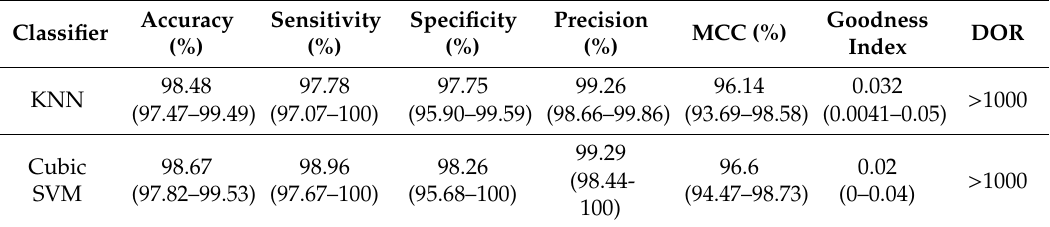
Table 9. Performance metrics (95% CI) for predicting stress and non-stress with Fp1 and Fp2 electrodes using leave-subjects-out cross validation.